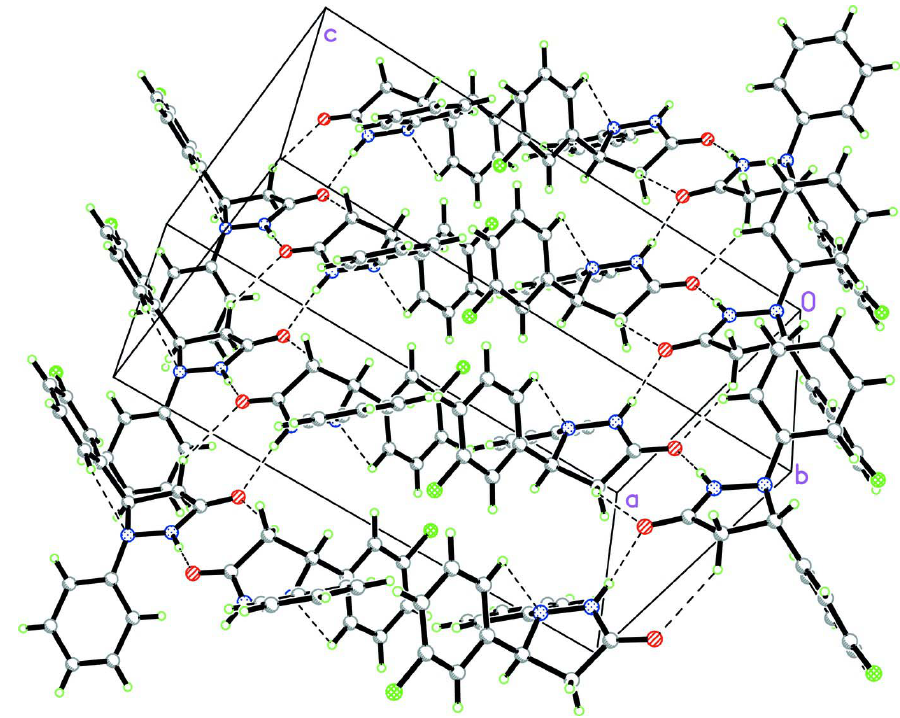
Figure 2 A partial packing diagram of the title compound. Hydrogen bonds are shown as dashed